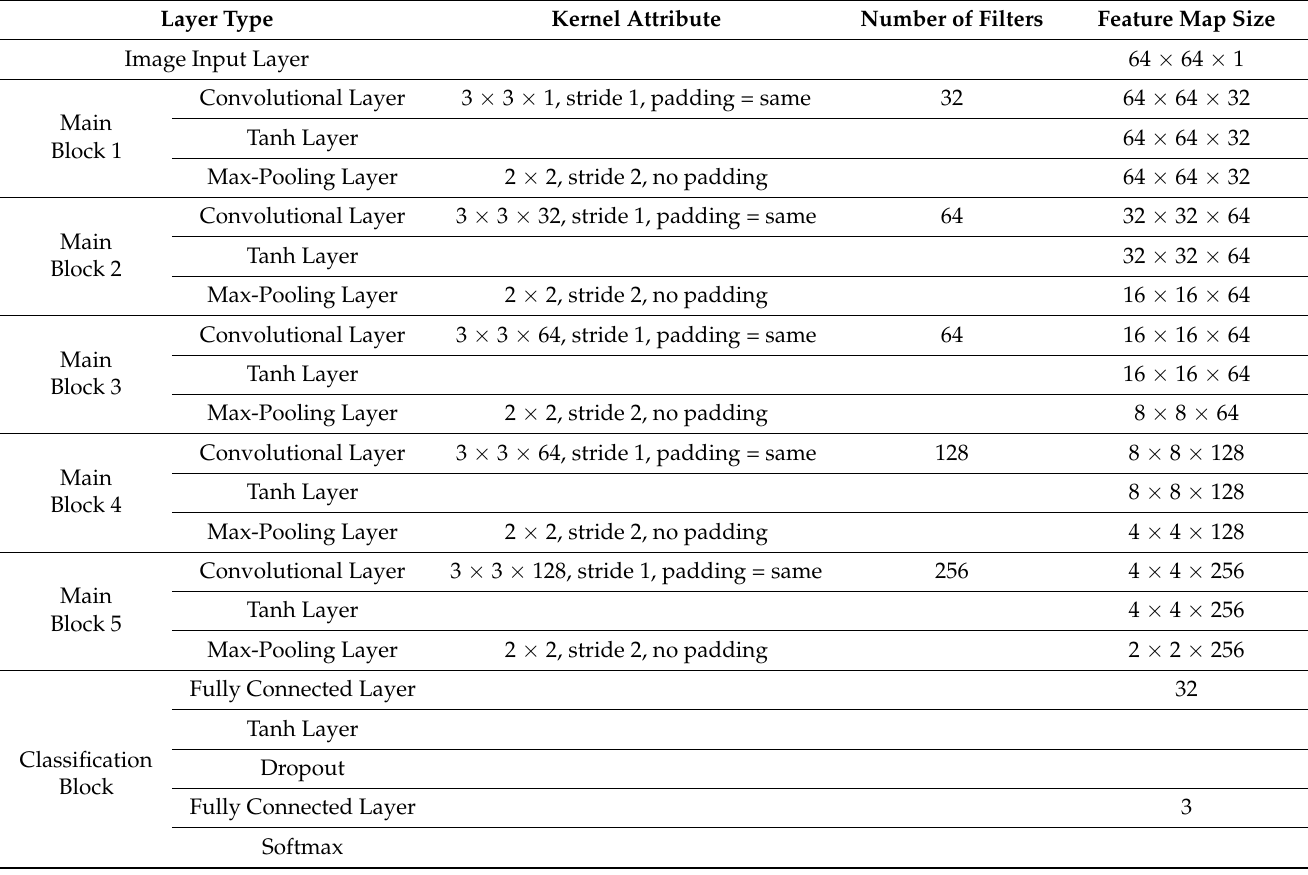
Table 5. Summary of the optimized